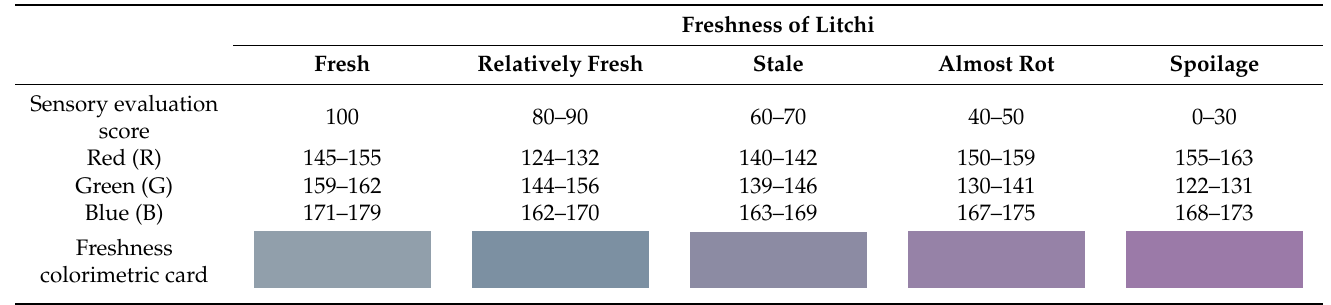
Table 6. Corresponding RGB values of the intelligent color rendering of litchi with varying degrees of freshness by double-layer antibacterial chromogenic